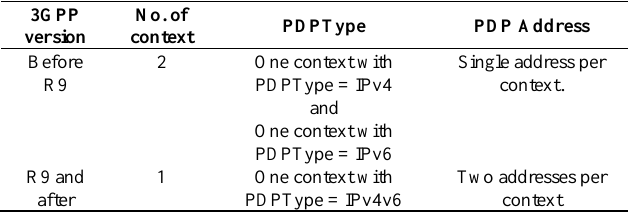
Table 1. Dual stack PDP context comparisons before and after 3GPP